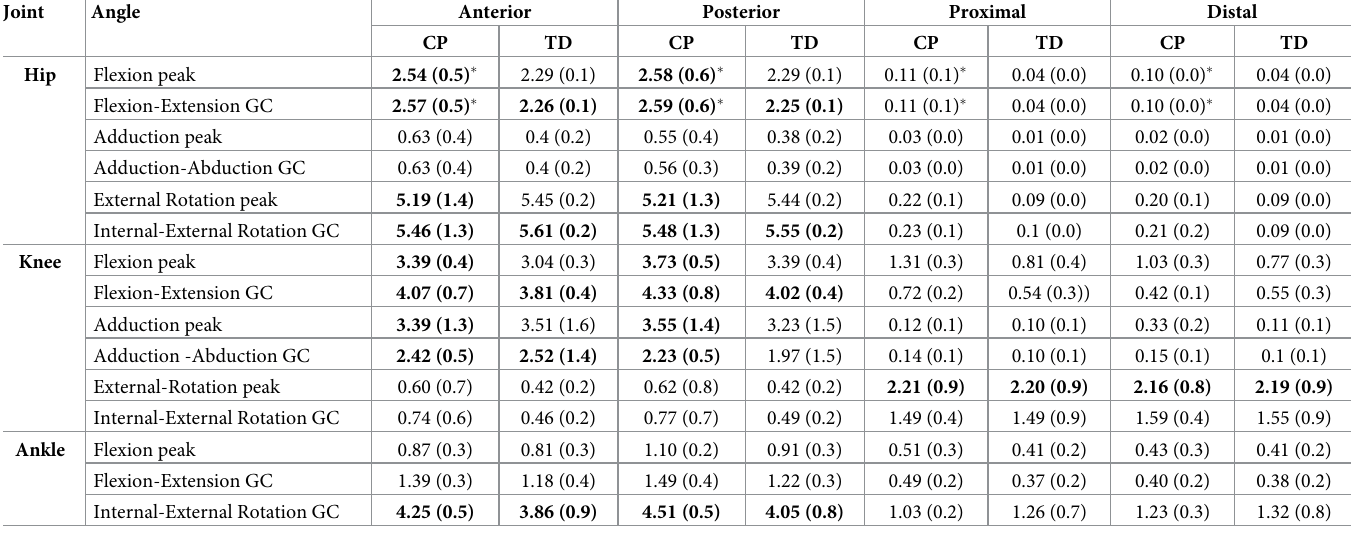
Table 1. RMSD (standard deviations) representing kinematic impact after 10 mm KNE marker misplacement. Values of RMSD represents the mean difference observed among both populations considering the complete gait cycle and for the CP group considering. Bold fonts represent the values of RMSD over 2˚. RMSD differ- ences between CP and control group (TD) evaluated by the p-value for AP and PD directions.